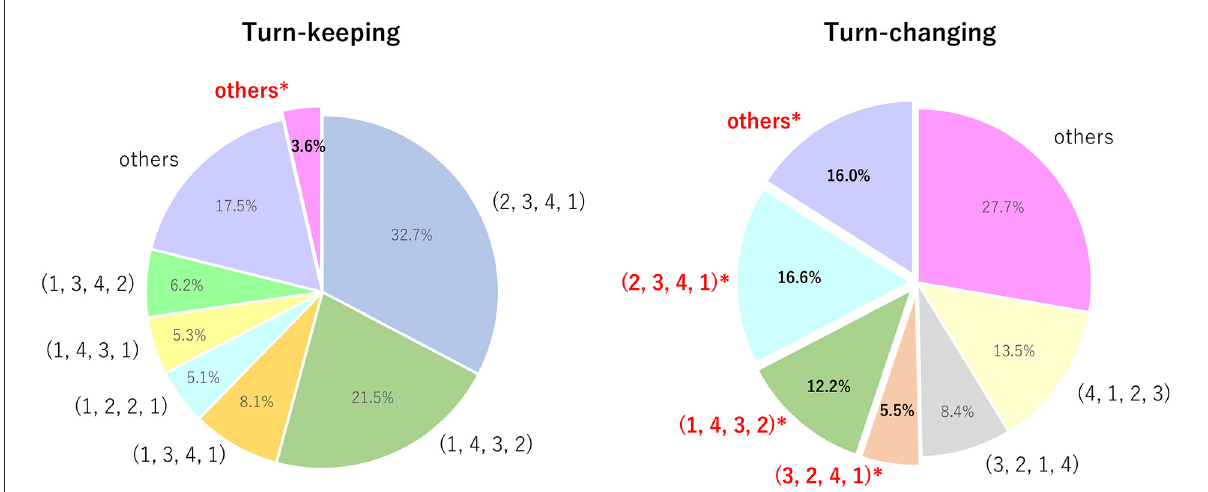
FIGURE5 Frequency of willingness combination patterns for turn-keeping (left) and turn-changing (right). ( r SS , r SL , r LS , r LL ) indicates ranks of speaker’s and listener’s speaking and listening willingness, where highest value was ranked as 1. “others" includes patterns taking up less than 5 % . Cases of conflict are marked with ∗ , which means that actual turn-changing/keeping was against participants’ willingness. Detailed analysis is given in Section